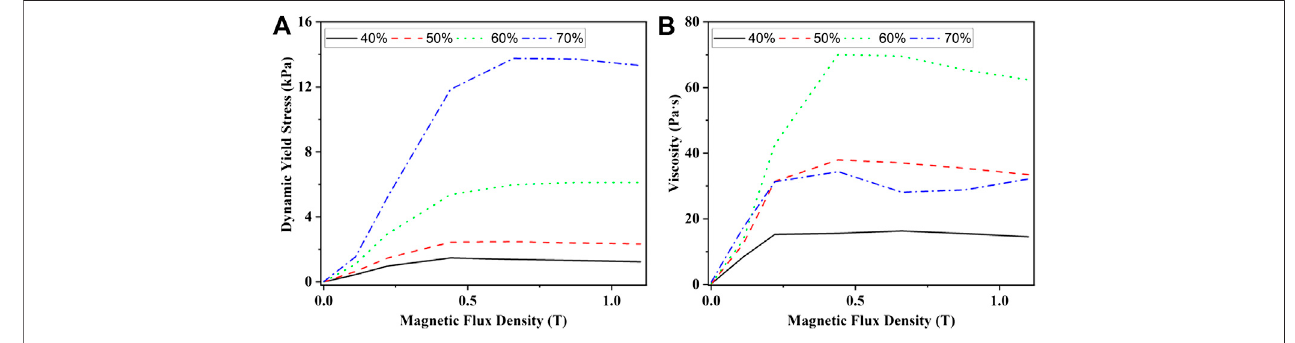
FIGURE 5 | The yield stress and viscosity of the samples.